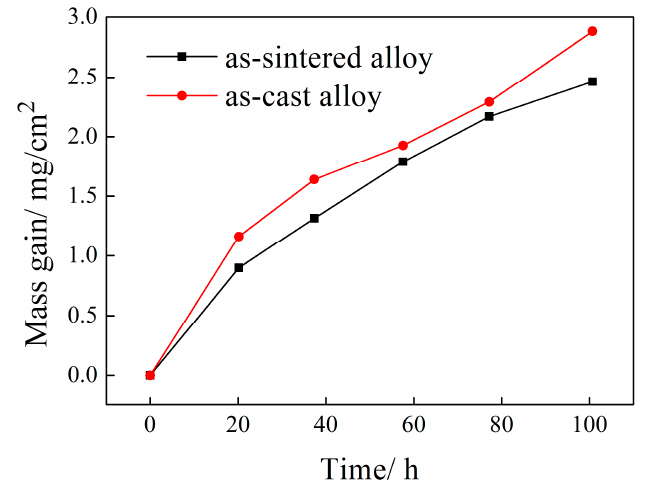
Figure 10. The isothermal oxidation kinetics of the alloys at 900 °C in air.